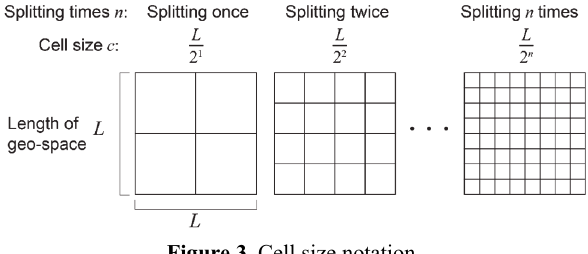
Figure 3 . Cell size